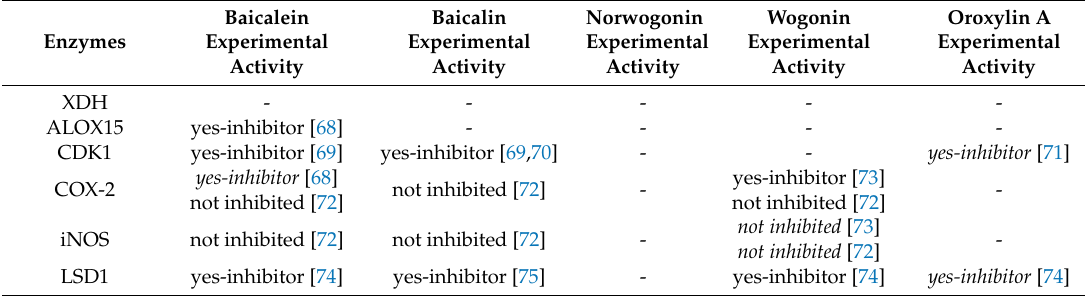
Table 7. Experimental results obtained from the literature regarding the biological activity between human enzymes from our study and S. baicalensis flavones. The italics represent experimental data that di ff er from our